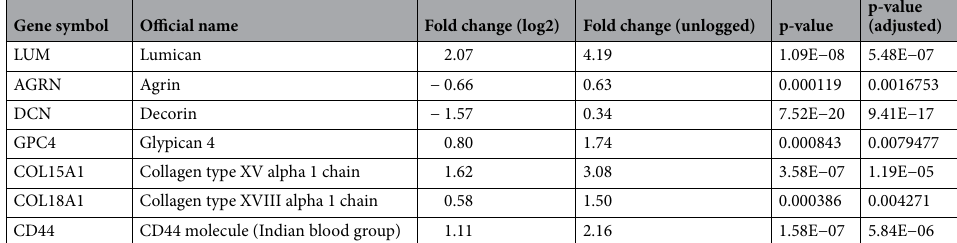
Table 3. Significantly regulated proteoglycans in glomeruli from patients with diabetic kidney disease compared to control.